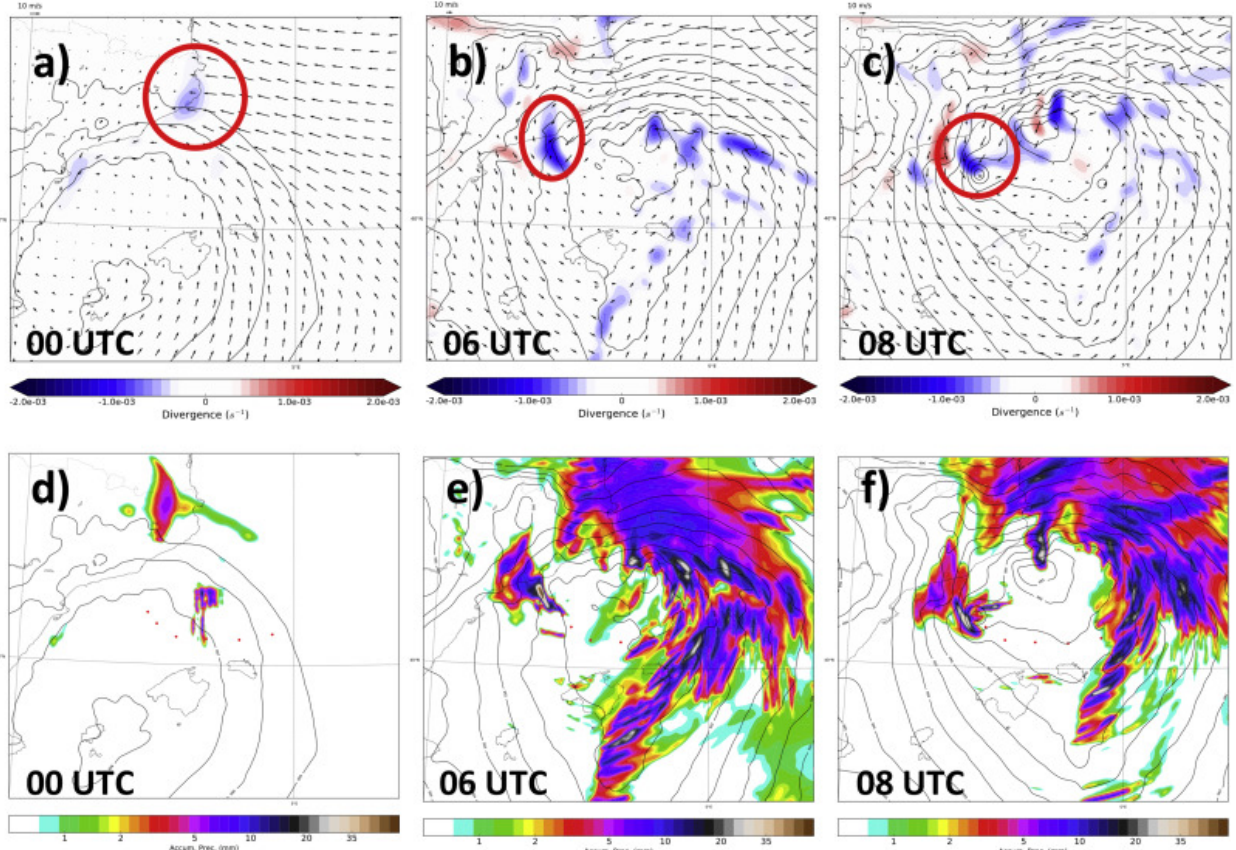
Figure 7. Control surface divergence, horizontal winds and mean sea-level pressure (a–c) , as well as hourly accumulated precipitation, together with mean sea-level pressure (d–f) , depicted at (a, d) 00:00UTC, (b, e) 06:00UTC and (c, f) 08:00UTC on 31 October 2012. The red circle highlights locations of low-level convergence associated with triggering of the secondary cyclone. Reprinted from Carrio et al.